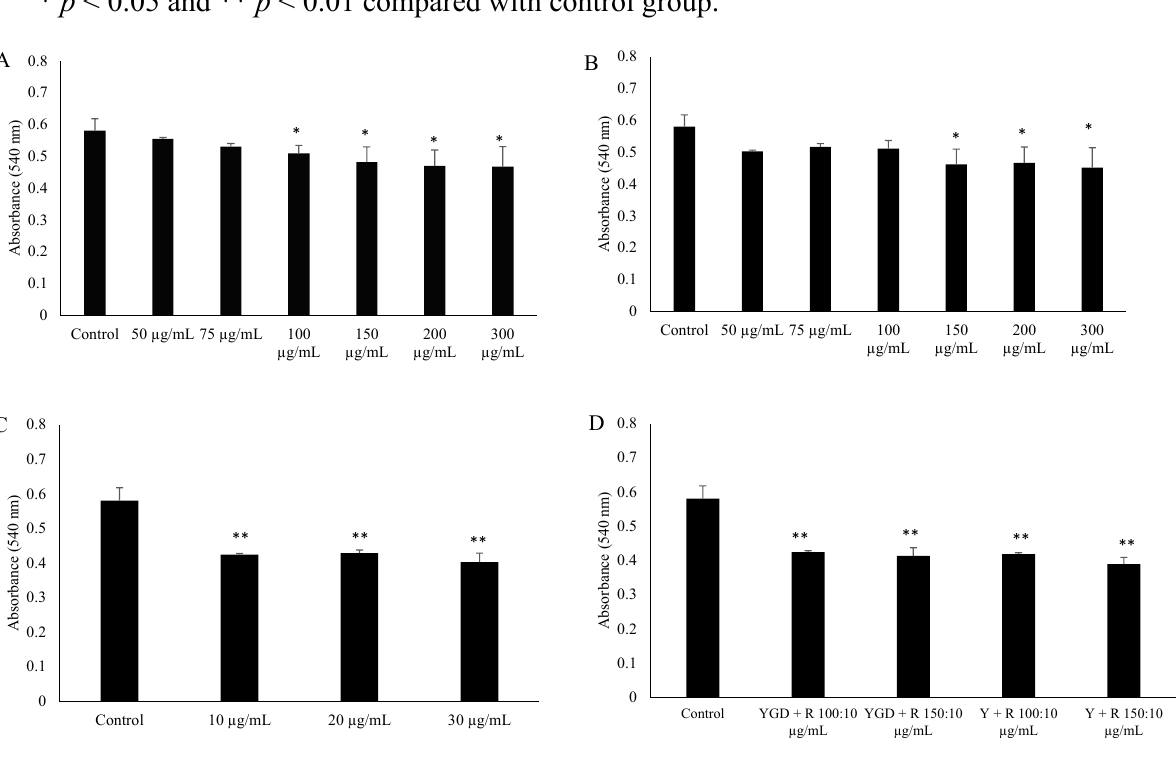
Figure 1. Effect of ( yerba maté , guarana and damiana) YGD ( A ); yerba maté ( B ); resveratrol ( C ) or mixed compounds ( D ) on adipogenesis in 3T3-L1 cells according to Oil Red O Assay. * p < 0.05 and ** p < 0.01 compared with control